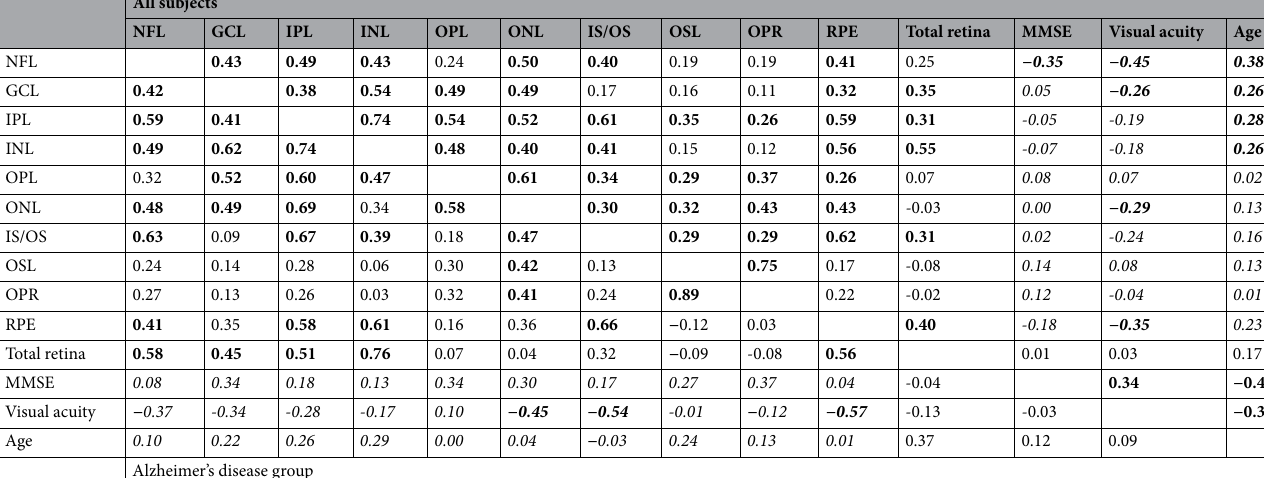
Table 3. Roughness correlations. Mutual correlations of layer roughness and Alzheimer’s disease-related variables for the whole sample (upper triangular matrix) and for the Alzheimer’s disease group (lower